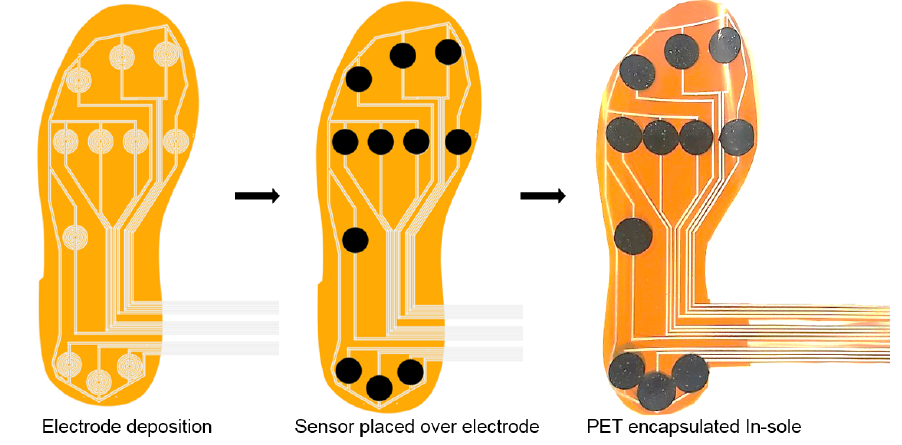
Figure 9. Schematic representation of fabrication of the in-sole with MWCNT/PDMS pressure